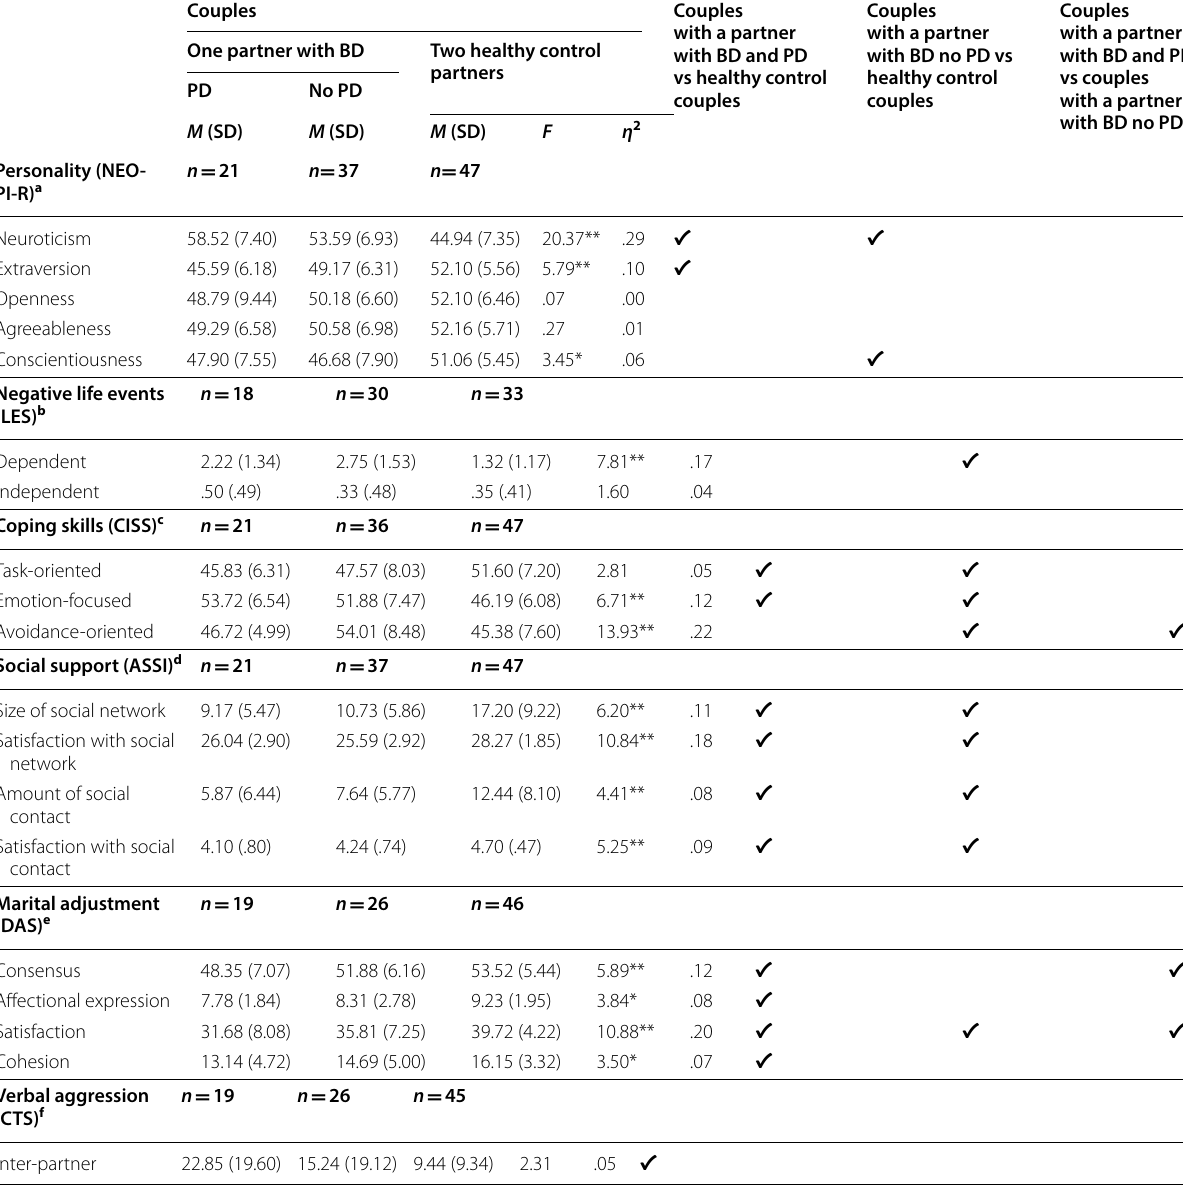
Table 3 Comparisons of personality traits, psychosocial functioning and marital adjustment of couples with a partner with bipolar disorder, with and without a comorbid personality disorder, and healthy control